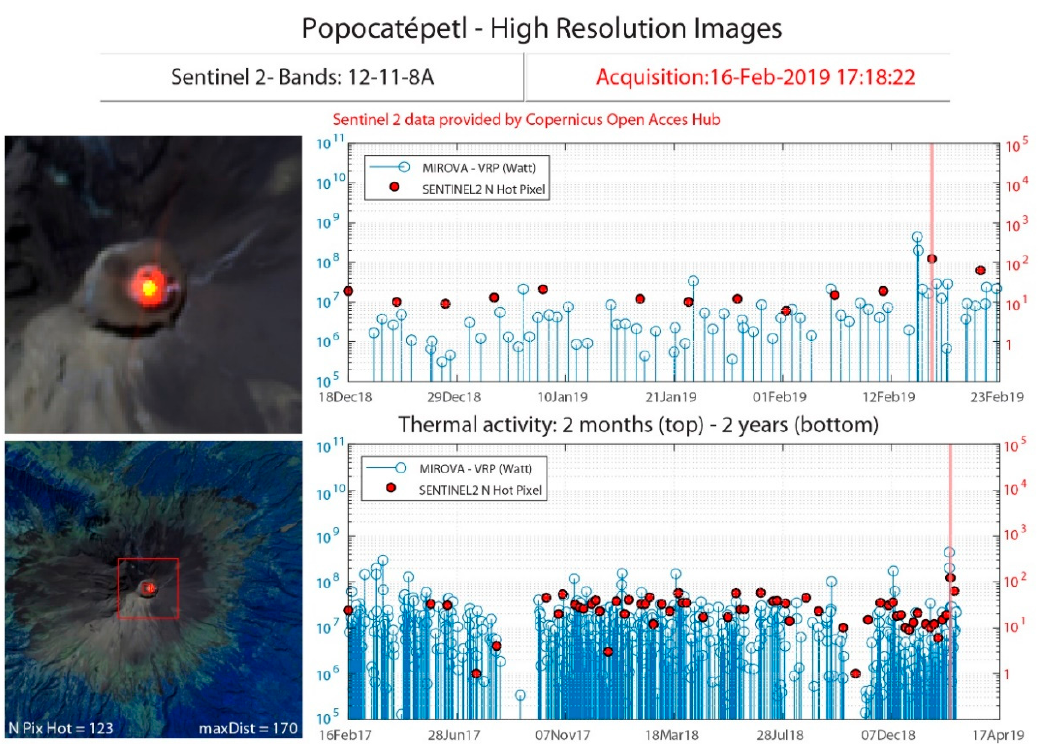
Figure 15. Model of output integration of SENTINEL-2 MSI and MODIS–MIROVA thermal data on Popocatépetl volcano. Left panels show the SENTINEL-2 RGB (bands 12, 11 and 8a). On the top-left, a 2 × 2 km zoomed-in view over crater area; on the bottom-left, a 10 × 10 granule with an estimation of the number of hot pixels and the maximum distance of hot pixels from the volcano summit [86]. On the right, two thermal y-logarithmic timeseries, two months and two years on the top and bottom respectively, with MIROVA thermal flux in Watt, blue stems, and S2Pix in red dots.